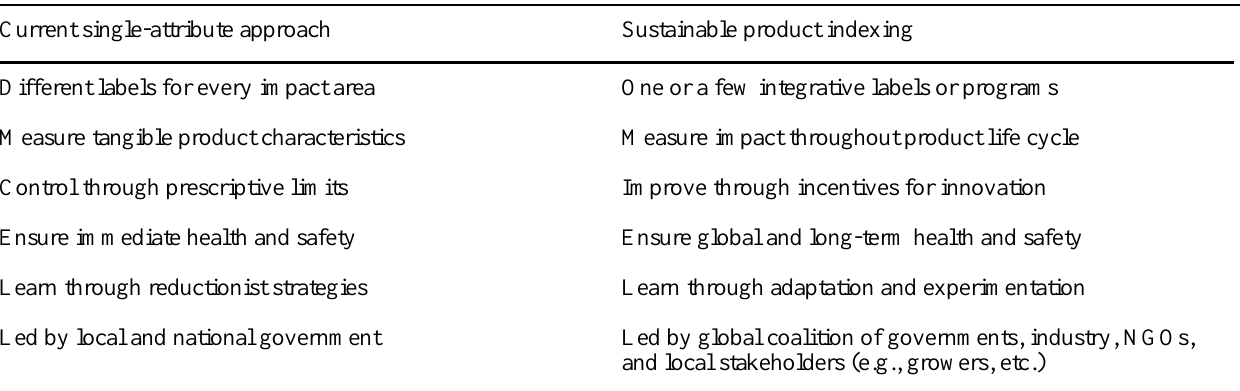
Table 1. Different approaches to improving product